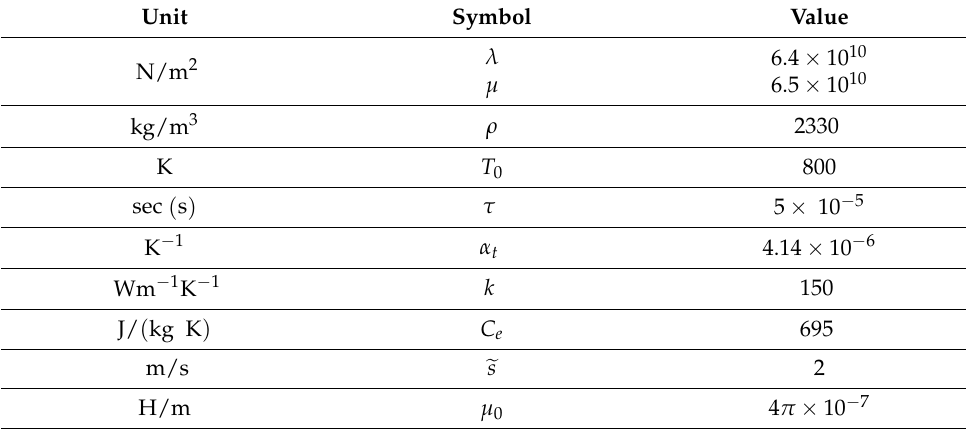
Table 1. The physical parameters in SI units for Si